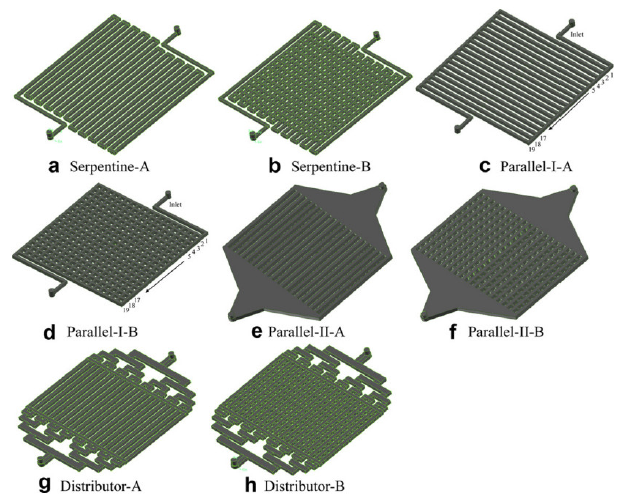
Figure 34. The studied flow fields/channel configurations for heat sinks [139]. Reprinted with permission from Ref. [139]. 2011, Elsevier.